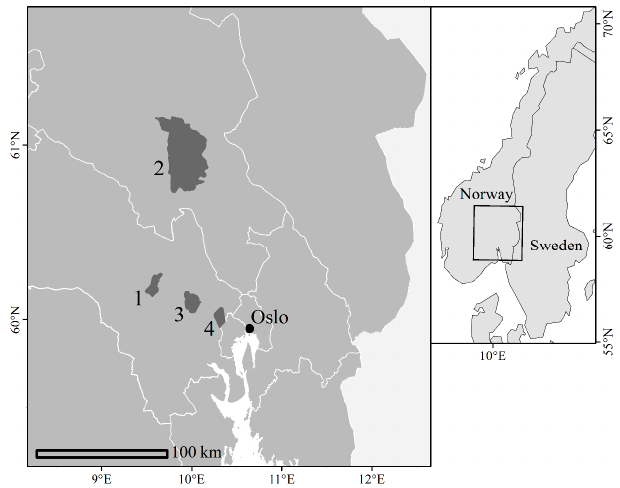
Figure 1. Map of southeastern Norway showing the location of the four districts. White lines represent county borders.